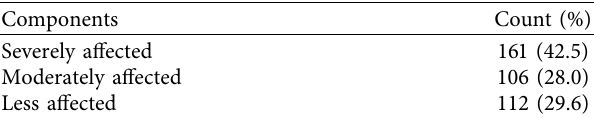
Table 3: Prevalence of cyberchondria among the participants.